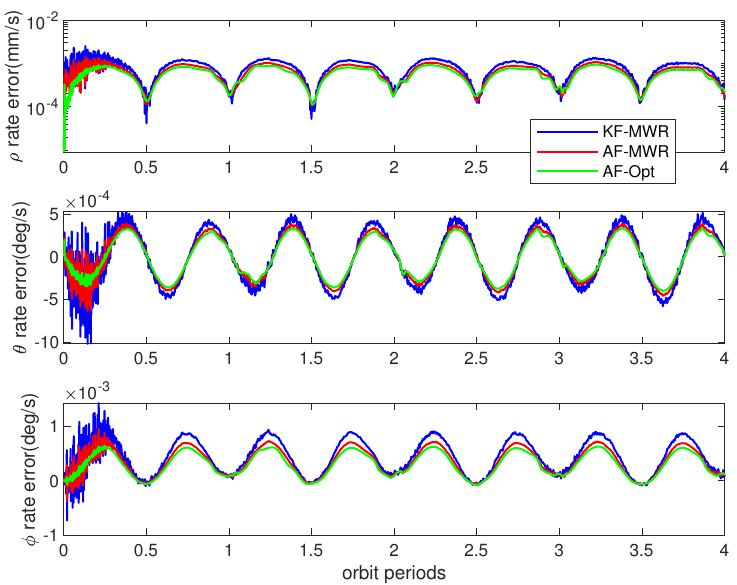
Figure 15. Relative range rate and azimuth/elevation angle rate estimation errors from different payloads and filters (refer to Figure 14 for the denotation of color lines).